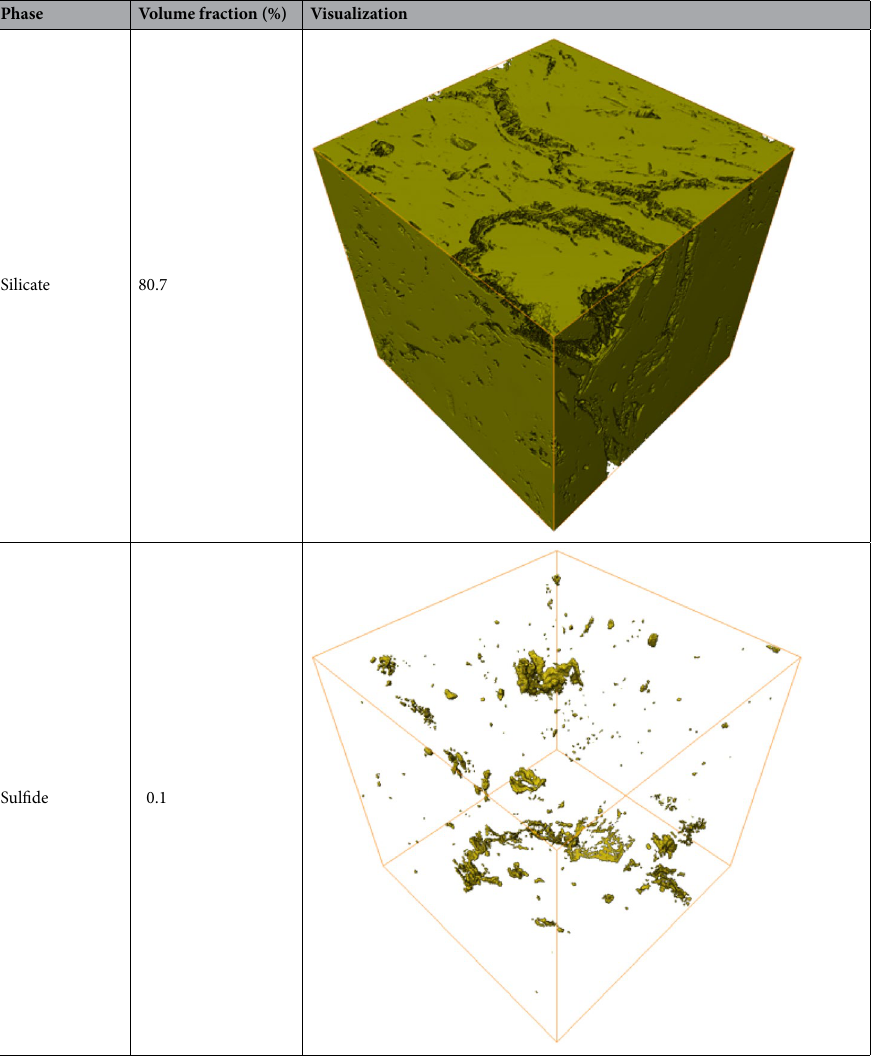
Table 1. Visualization of segmented pore, organic, and non-organic (mineral) phases of the digital rock 3D